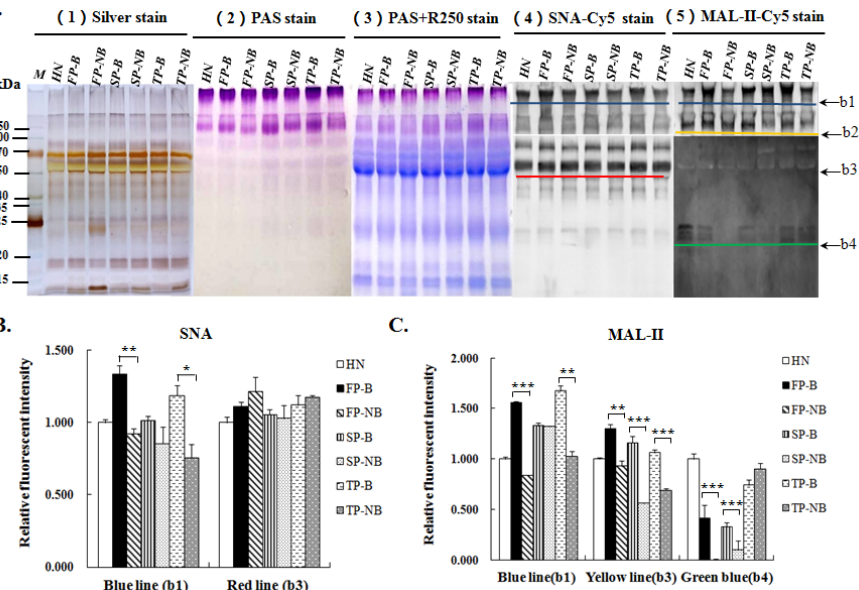
Figure 2. Analysis of the salivary proteins profiles and the variation in terminal α 2-3/6-linked Sia expression level on glycoproteins of different groups. ( A ) Salivary proteins and glycoproteins from different groups were shown by the silver stain (1), PAS stain(1) and the combine of PAS and Coomassie Brilliant Blue R-250 stains (3), and the salivary proteins glycosylated with terminal α 2-3/6-linked sialic acids were detected by the lectin blotting analysis of Cy5-labled SNA (4) and MAL-II (5). ( B ) Relative fluorescence intensities (RFIs) of the binding bands of salivary proteins to Cy5-labled SNA. ( C ) RFIs of the binding bands of salivary proteins to Cy5-labled MAL-II. Data shown are mean ± SD, * p < 0.05; ** p < 0.01; *** p < 0.001.